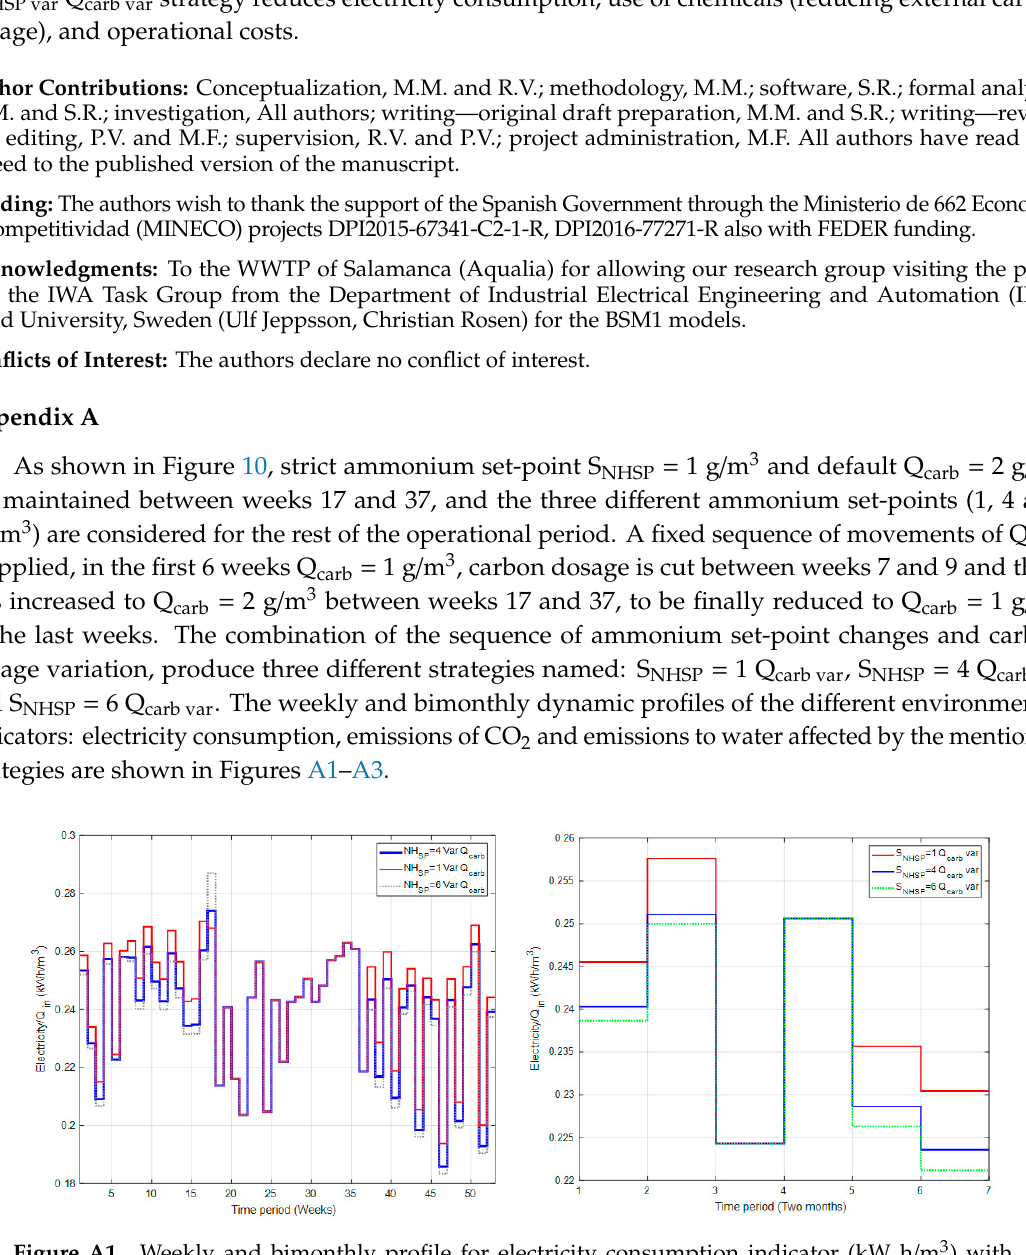
Figure A1. Weekly and bimonthly profile for electricity consumption indicator (kW h/m 3 ) with alternative control actions.